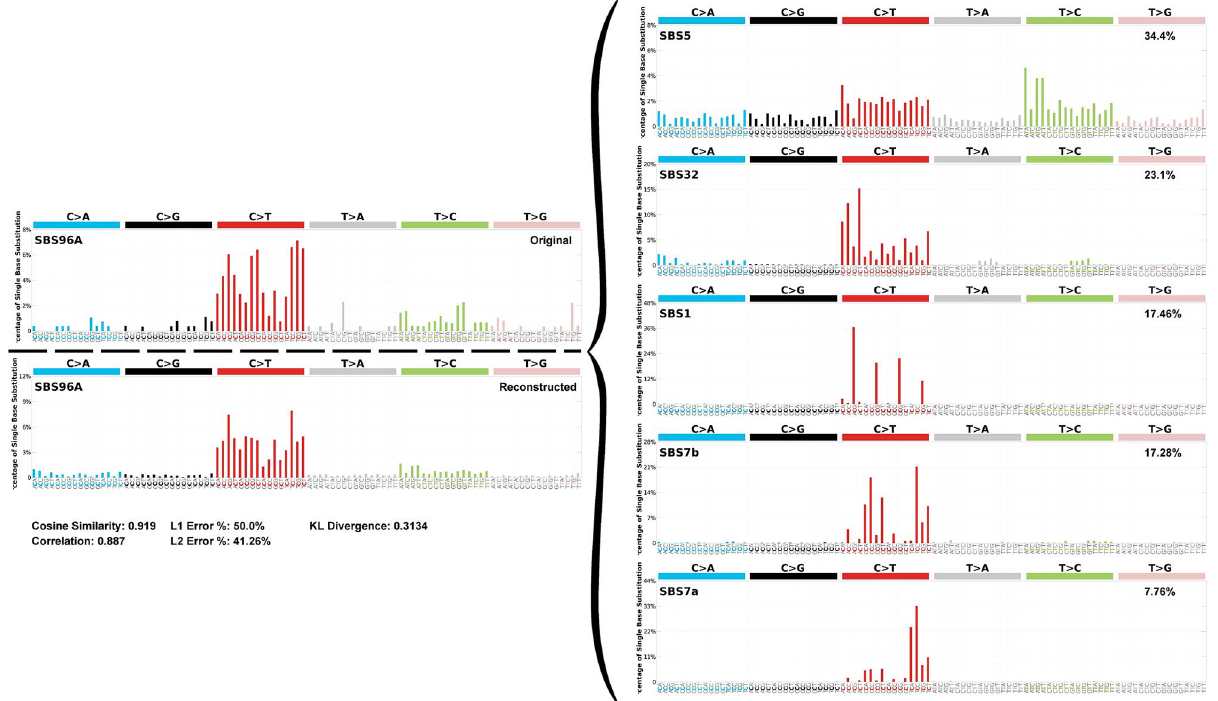
Figure 2. Decomposition plots of mutational signature analysis with primary samples (n = 13). Plots of Original and reconstructed data (left) and decomposed 5 mutational signature plots